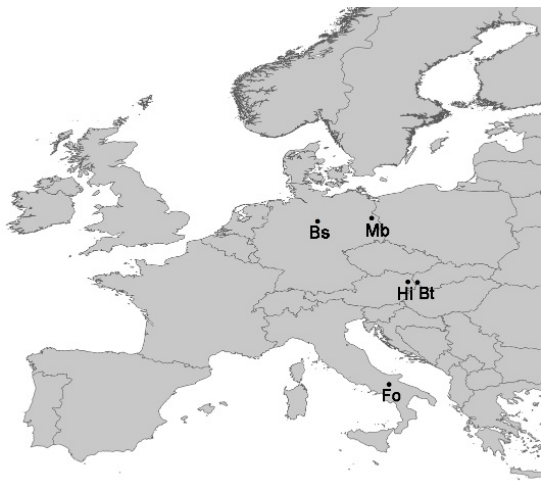
Figure 1. Location of the experimental sites.